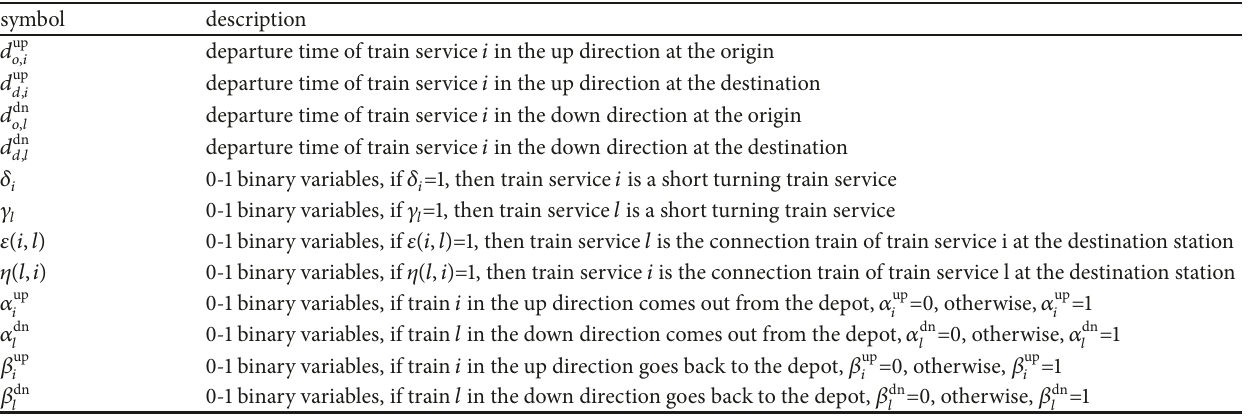
Table 3: Decision